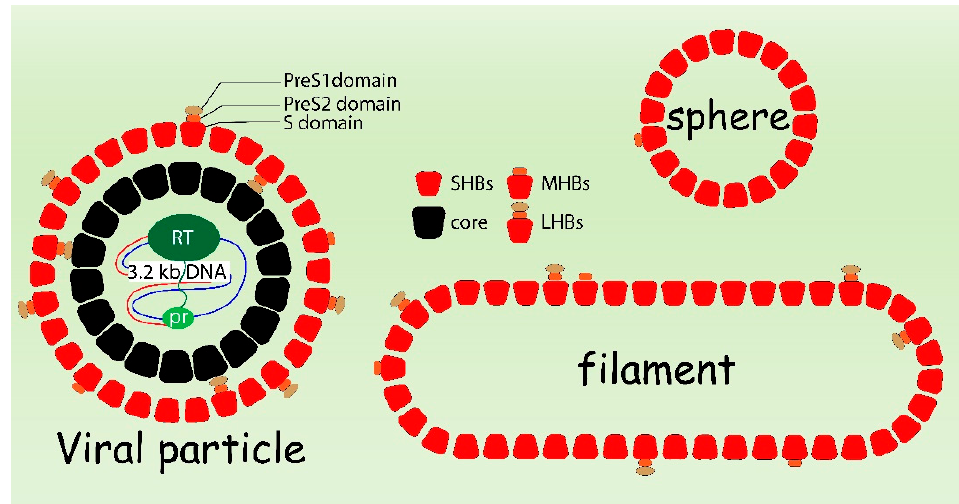
Figure 1. Schematic presentation of HBV viral particle, subviral filament and sphere.